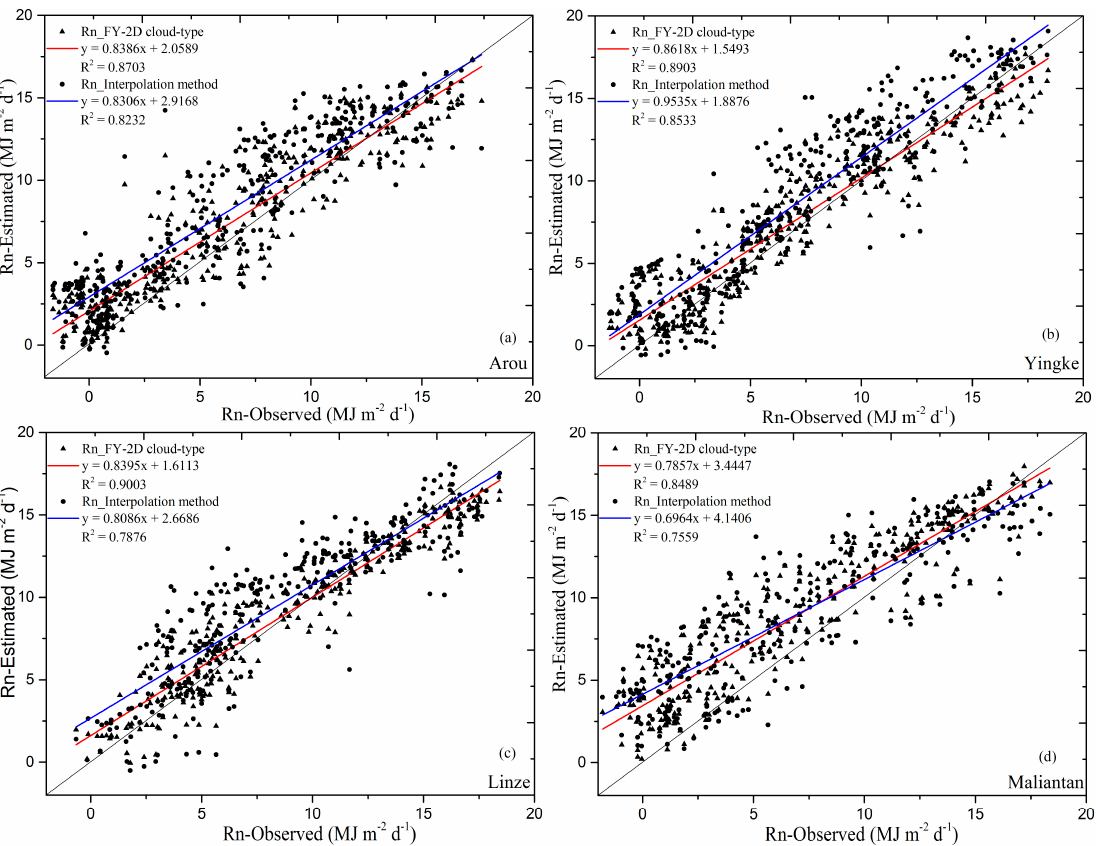
Figure 3. Comparison of the observed and estimated daily net radiation in 2008 (366 days) at Arou ( a ); Yingke ( b ) Linze ( c ) and Maliantan ( d ) stations. Table 6. Statistics for the performance of daily net radiation estimated by the proposed method at the Arou, Yingke, Linze and Maliantan stations in 2008 (366 days).